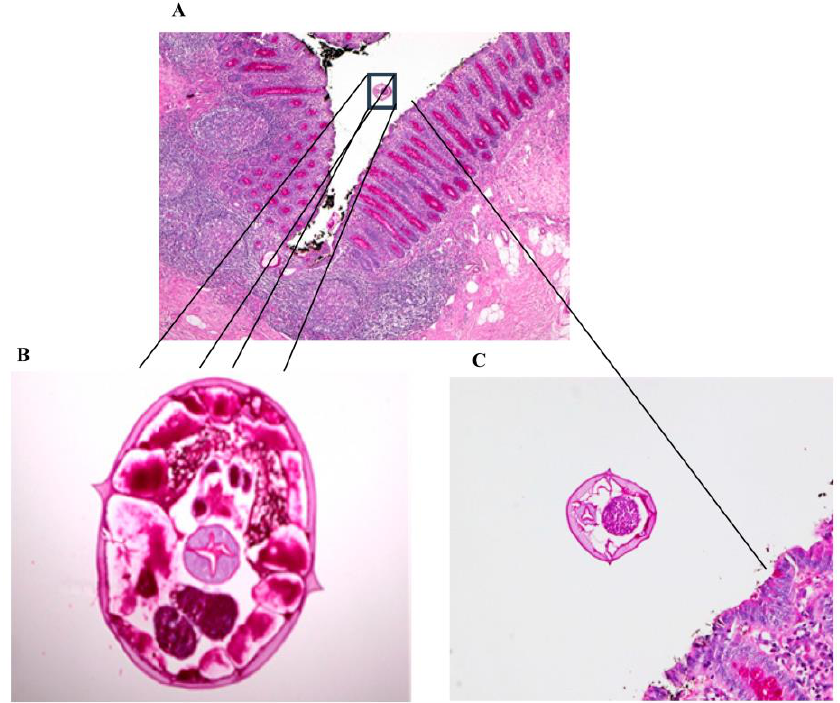
Figure 3. ( A ) Periodic acid–Schiff (PAS), magnification 40×. ( B ) Periodic acid–Schiff (PAS), magnifi- cation 200×, of female Enterobius vermicularis worms with eggs. ( C ) Periodic acid–Schiff (PAS), mag- nification 200×, showing worm in the lumen.